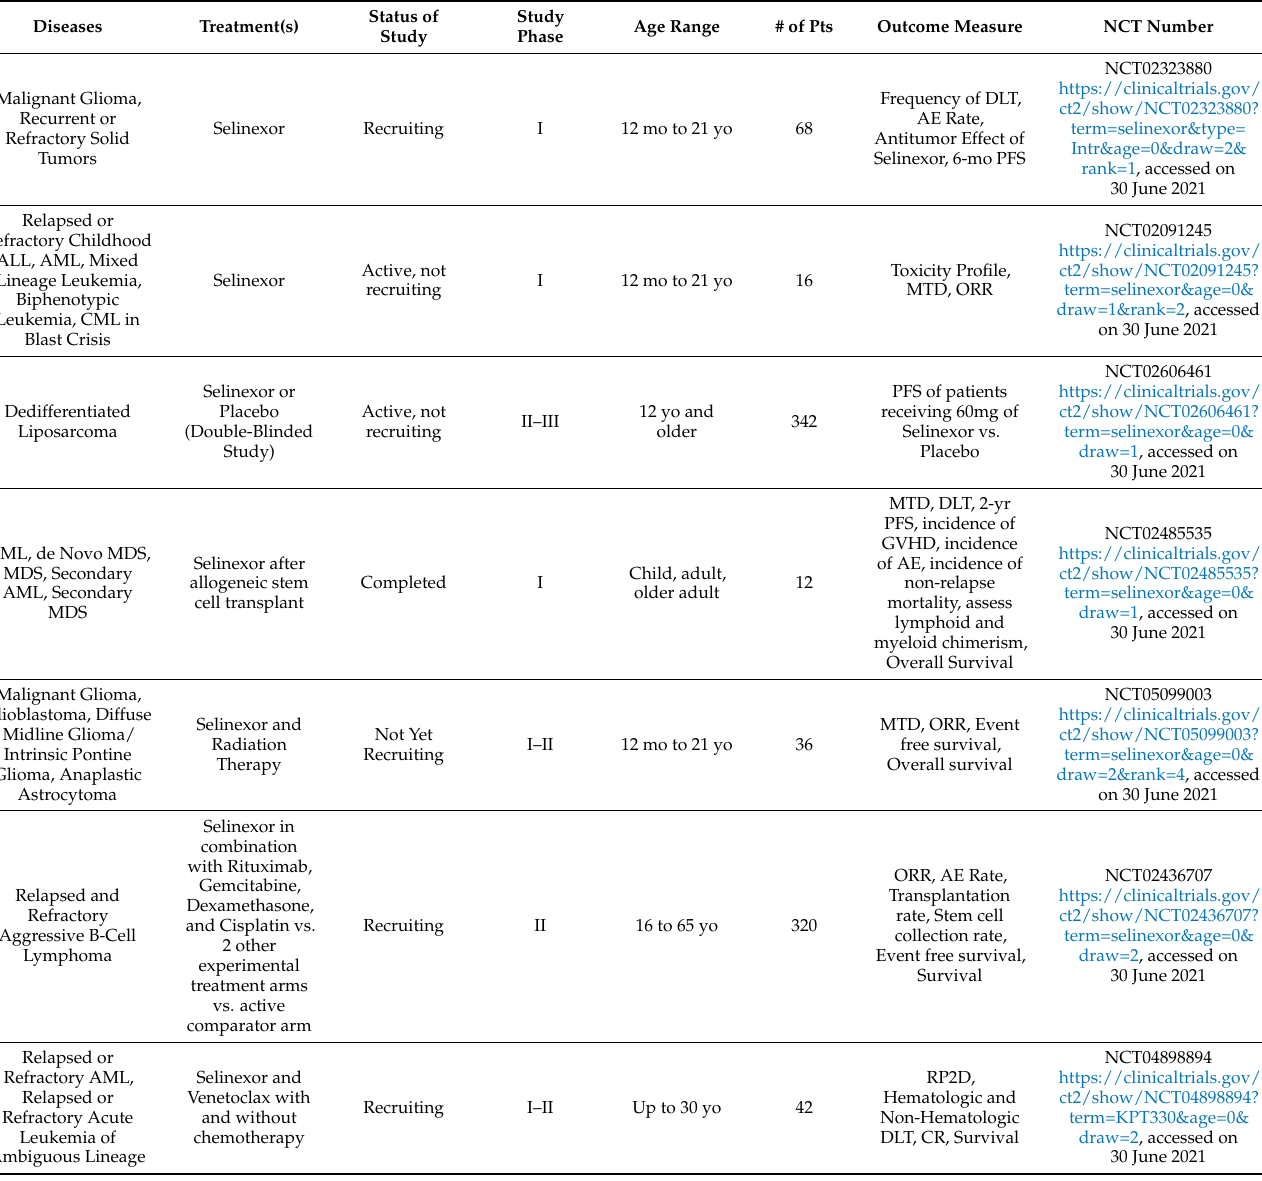
Table 2. Overview of clinical trials involving selinexor in childhood